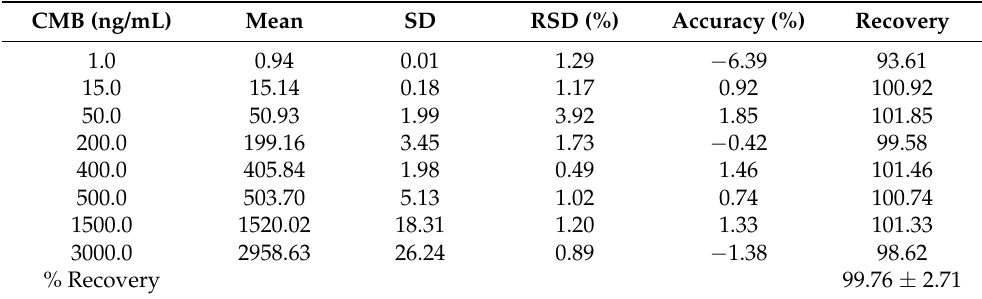
Table 4. Summary of back-calculation data of six calibration curve repeats (calibration levels) of